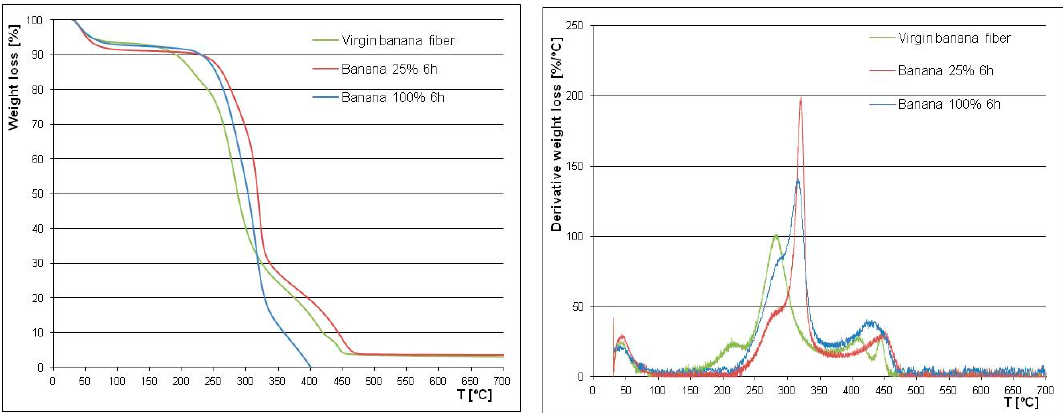
Table 6. Degradation temperatures (in °C) of virgin and treated banana fibers.